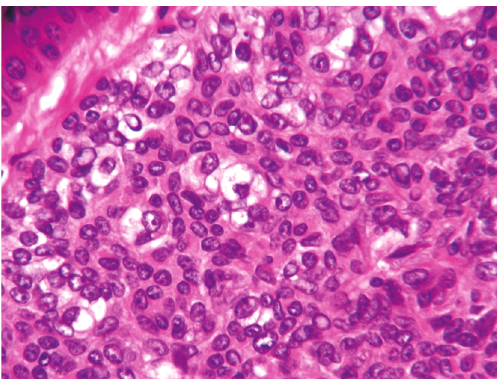
Figure 6: A few sebocytes are seen at the periphery of the tumor nests.